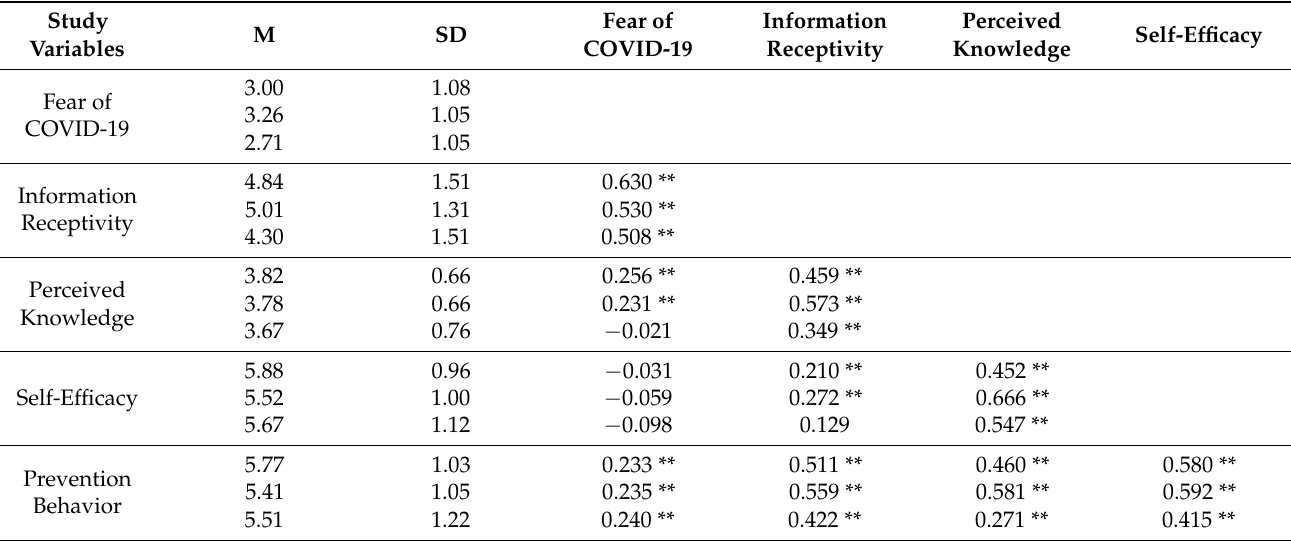
Table 3. Means, Standard Deviations, and Correlation Coefficients for Focal Study